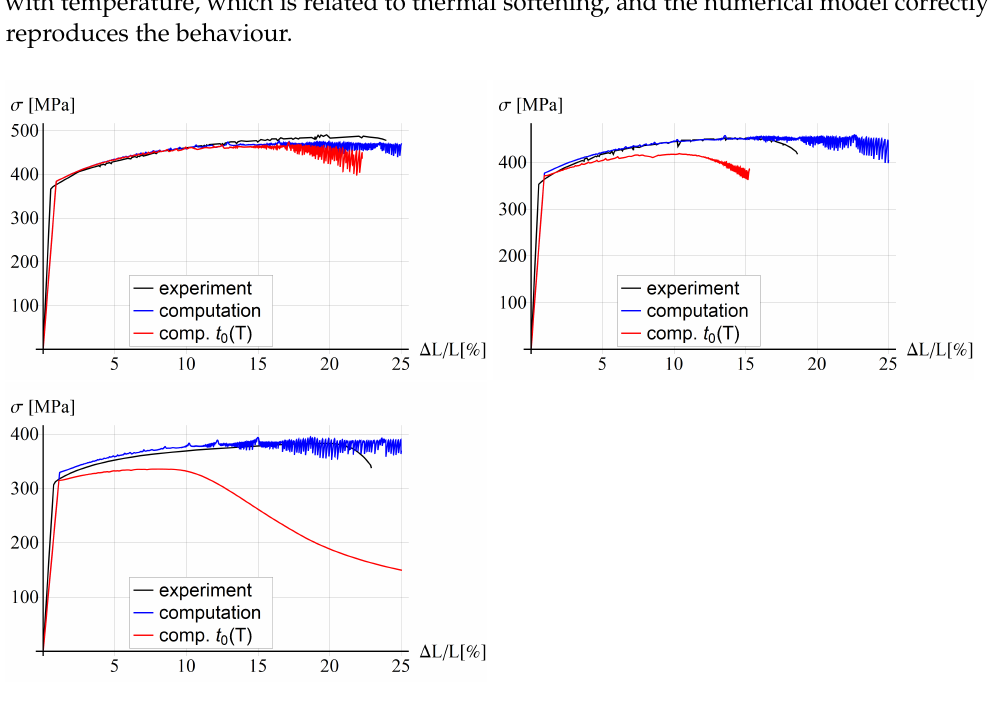
Figure 5. Stress vs. relative extension for thermo-visco plastic model for 25 ◦ C ( left , top ), 100 ◦ C ( right , top ), 200 ◦ C ( left , bottom